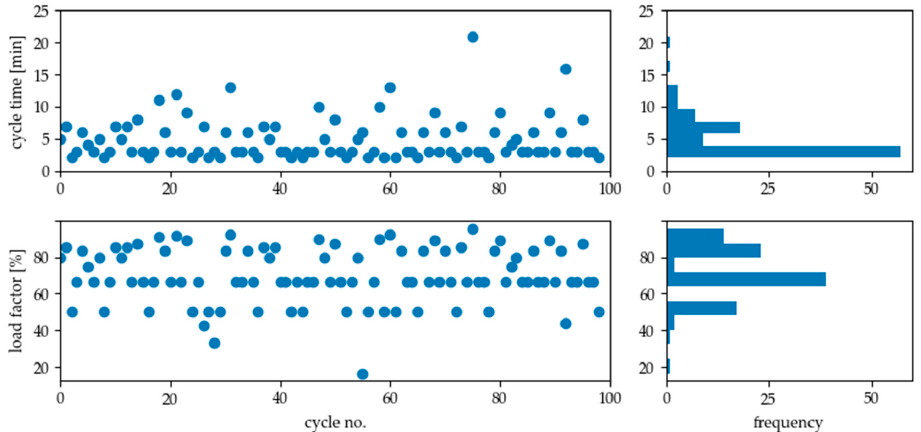
Figure 16. Result of load analysis for compressor during production (8 a.m to 4 p.m). The resulting average cycle time is 4.83 min, the mean load factor of all full cycles is 69.7%.